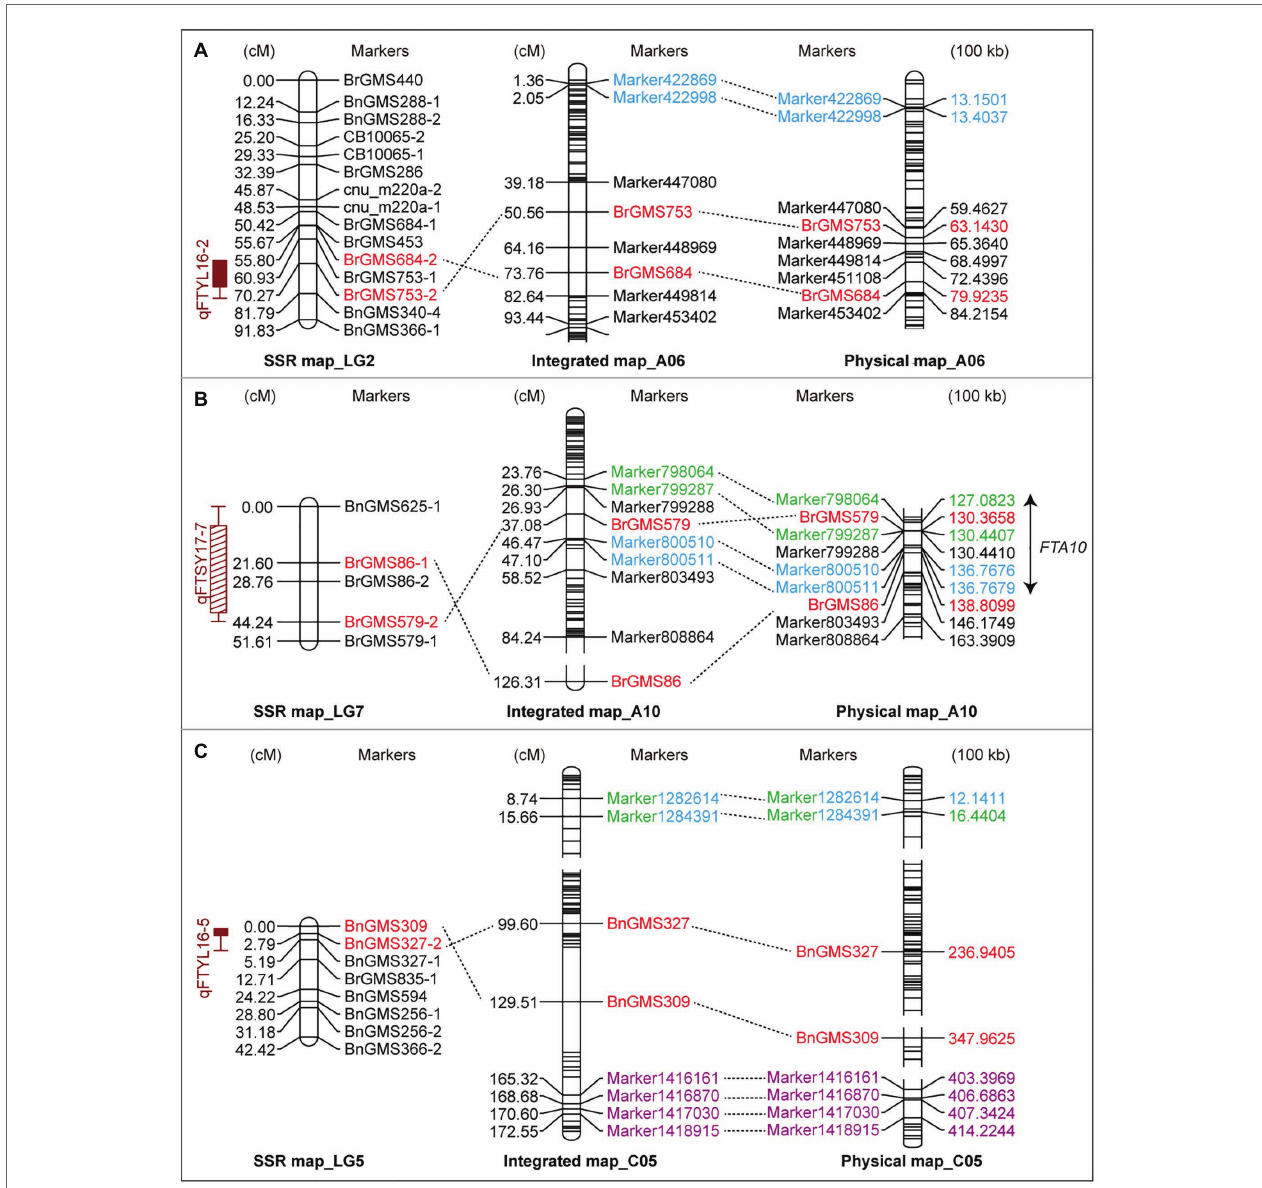
FIGURE 2 | The integrated linkage groups by jointing the simple sequence repeat (SSR) and specific-locus amplified fragment (SLAF) markers. The SSR-based genetic map (left), the integrated genetic map (middle), and the aligned physical map (right) in A06 (A) , A10 (B) , and C05 (C) chromosomes are shown. Red markers represent the loci detected on the SSR-based map using the flowering time in YL16 and SY17. Blue, green, and purple markers label the positions identified by the BOT, BUT, and FT traits in YL18 on the high-resolution genetic map (HRGM), respectively. The same markers among these maps are connected by dotted lines. The double arrow marks the co-localized interval FTA10 among these loci on A10. BOT, bolting time; BUT, budding time; FT, flowering; SY17, YL16, and YL18, the environments of Sanyuan in 2017, Yangling in 2016 and